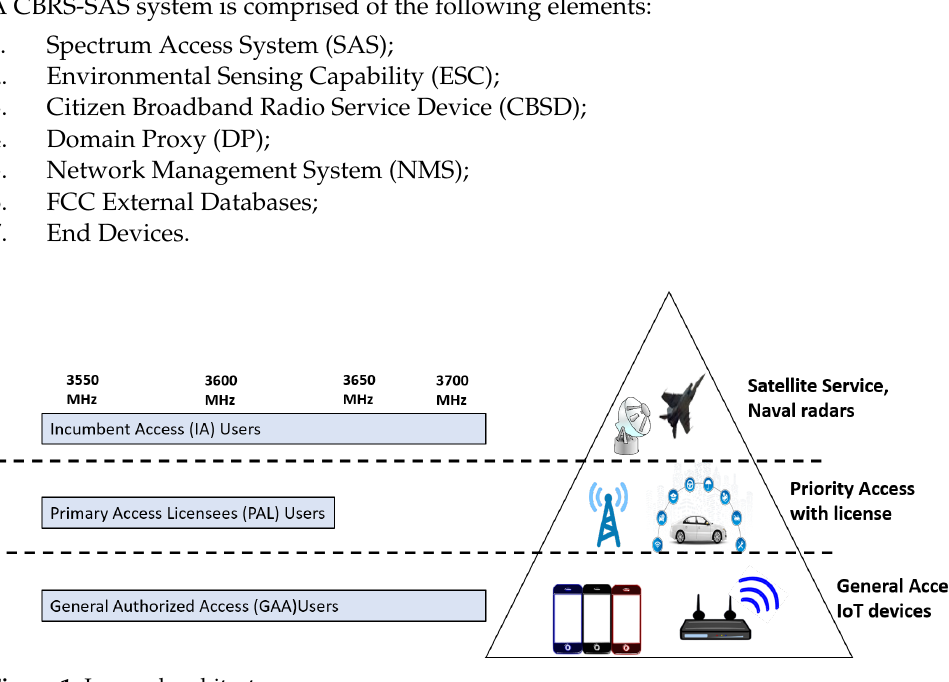
Figure 1. Layered